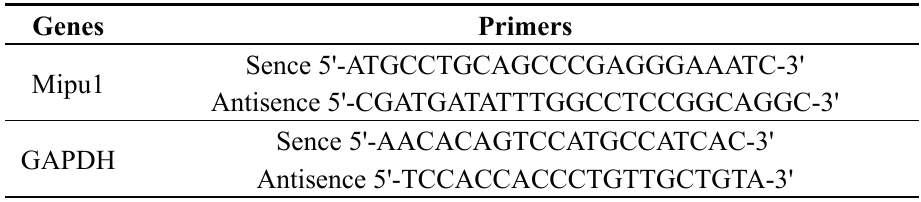
Table 1. The primers for the quantitative real-time